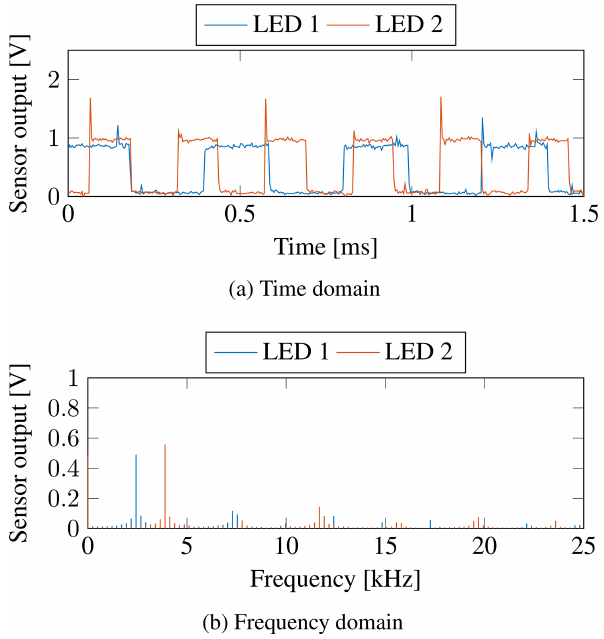
Figure 3. Amplitude modulation and frequency division multiplex- ing with sequential control of LED 1 and LED 2.